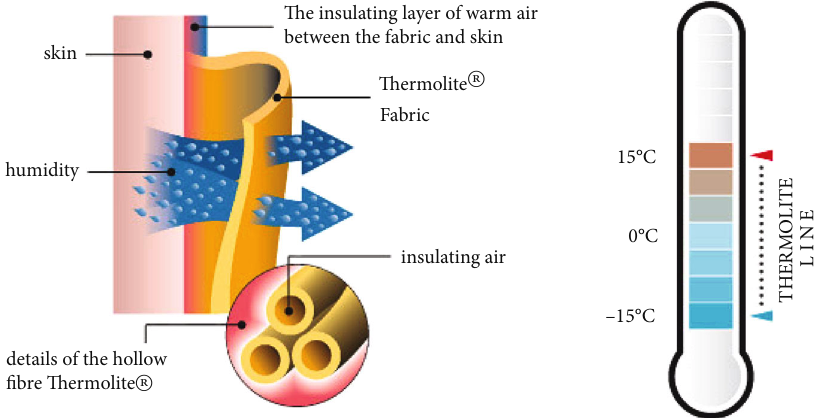
Figure 7: Thermal insulation mechanism in thermolite fi ber